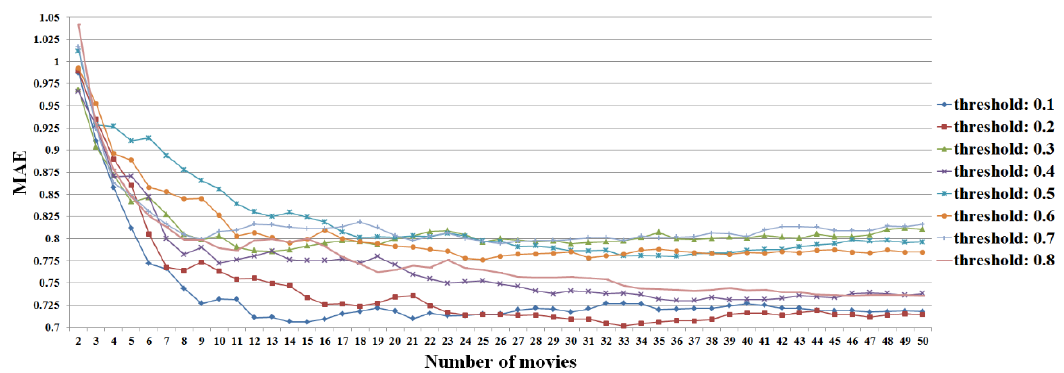
Figure 29. MAE values for the different numbers of ratings based on the cosine similarity in the item-based filtering.